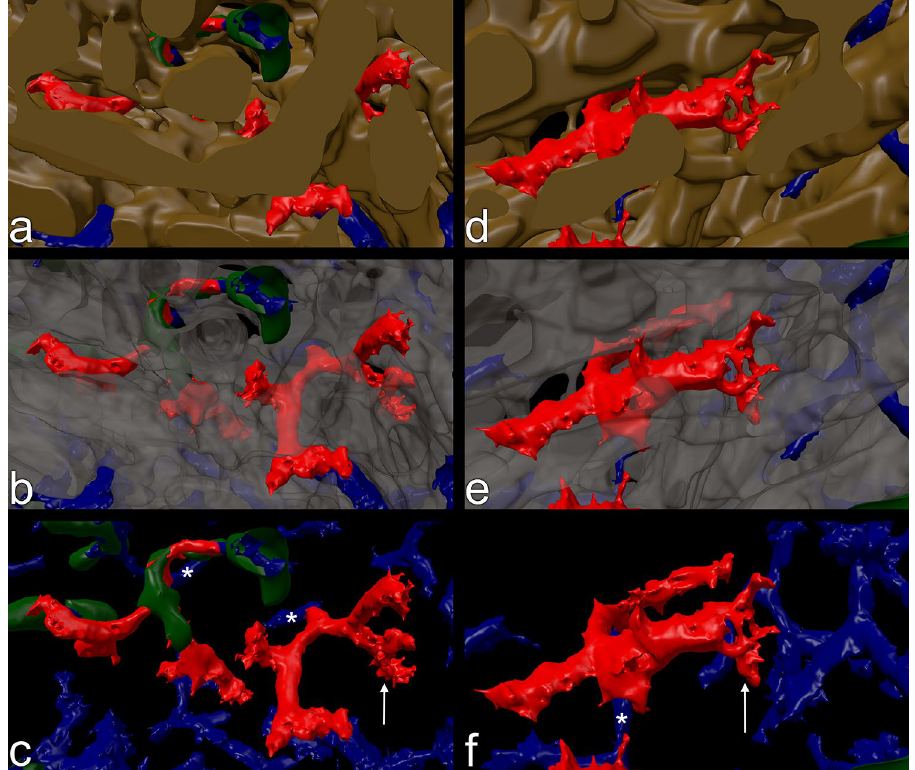
Figure 5. Models (ROI 3) of typical highlighted open ends (CD34 + , red) in the red pulp capillary network (CD34 + , blue) with sheaths (CD271 + , green) observed inside the sinus network (CD141 + , brown). ( a , d ) The sinus network occludes most of the red pulp capillaries. ( b , e ) Same as ( a , d ) with transparent sinus walls. ( c , f ) Same as ( a , d ) without sinuses. Note that open ends often tend to be localized shortly after dichotomous capillary branchings. In ( c ) the left capillary stem carries an extremely small sheath which is difficult to distinguish from aggregations of CD271 + non-sheath fibroblasts. The ends shown in ( c,f ) are visualized in 3D in Supplementary videos S1, S2, S3, S4. Asterisk in ( c ) and ( f ): capillary stem feeding the ends. Arrow in ( c ): end shown in Fig. 6a,b. Arrow in ( f ): end shown in Fig. 6c,d.